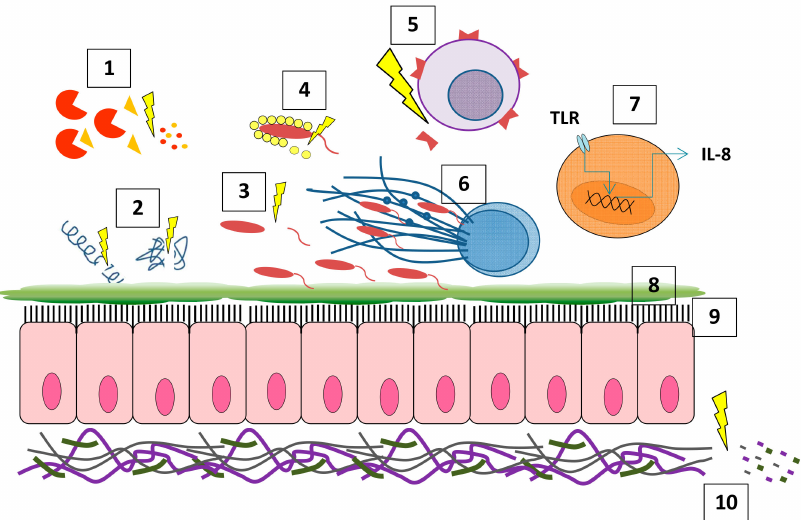
Figure 1. Neutrophil elastase (NE) has a wide range of e ff ects including: (1) cleavage of other proteases / antiproteases; (2) cleavage of antimicrobial peptides (AMPs); (3) cleavage of flagellin; (4) cleavage of opsonizing peptides; (5) cleavage of cell surface receptors; (6) neutrophil extracellular trap (NET) formation; (7) upregulation of pro-inflammatory cytokines; (8) upregulation of mucin genes; (9) impairing ciliary function; (10) degradation of extracellular matrix (ECM)